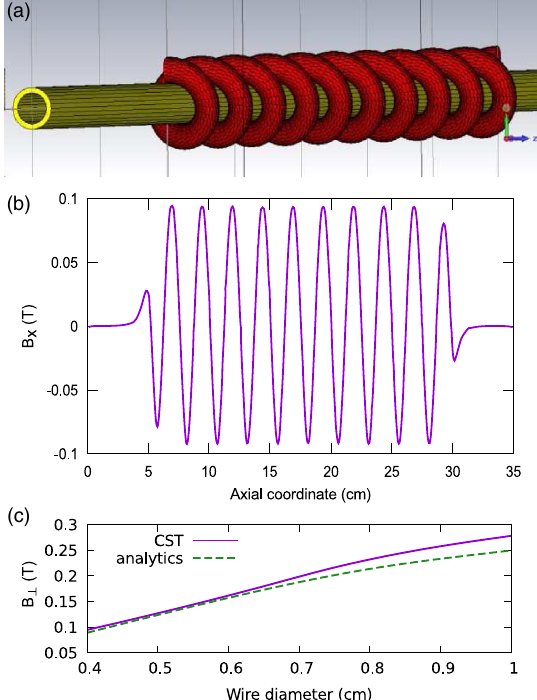
FIG. 3. Results of simulations within the CST Studio for the case of iron helix with round cross section, period of 2.5 cm, and inner radius of 5 mm. The helix geometry (a) and the amplitude of the transverse magnetic field as function of axial coordinate [(b), wire diameter is 0.4 cm] and of helix wire diameter [(c), maximum field amplitude]. The predictions of formula (6) for the equivalent square cross section are also shown (c).